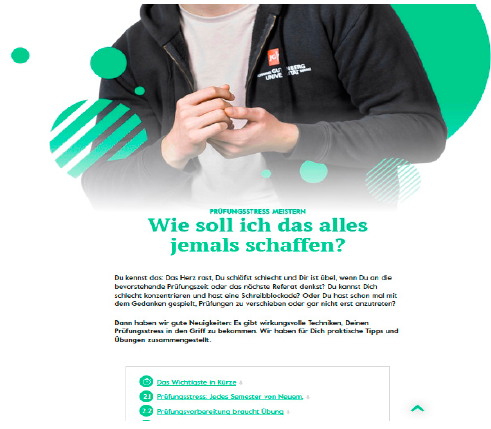
Figure A1. Chapter 2 “Mastering exam stress”.